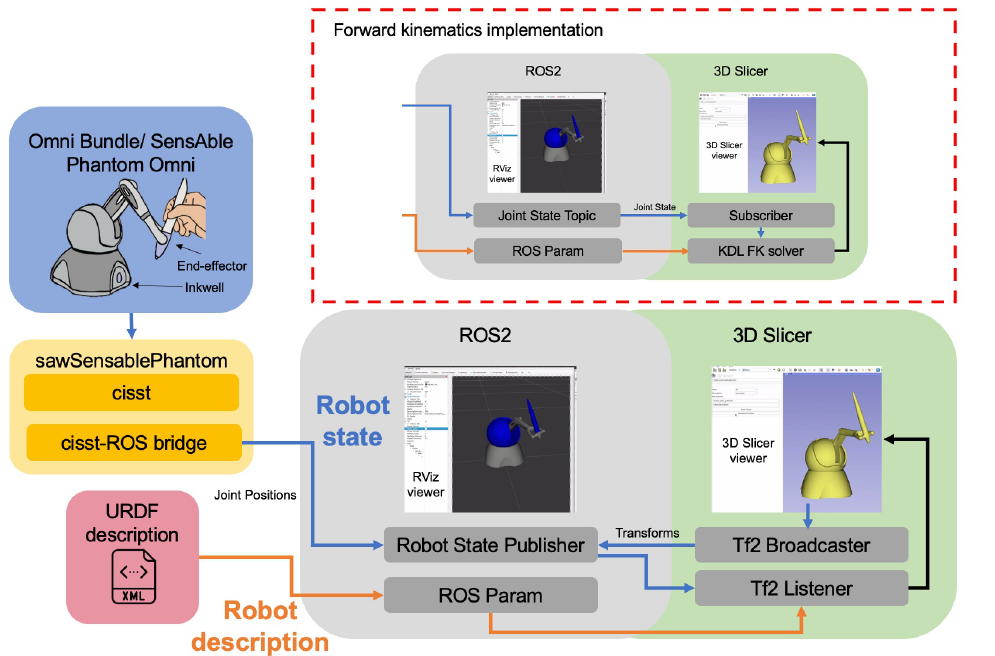
Figure 3. Overview diagram of the SlicerROS2 module. Green boxes indicate 3D Slicer features, while gray indicates ROS2 features. Blue arrows indicate connections specific to robot state, while orange indicates connections specific to robot description. The URDF description is loaded into ROS param to update the robot description in 3D Slicer. At the same time, the robot state publisher updates the Tf2 tree in ROS for 3D Slicer to listen and broadcast to. The upper right shows the same configuration using the other robot state alternative, which is computing the FK of the device directly in 3D Slicer.